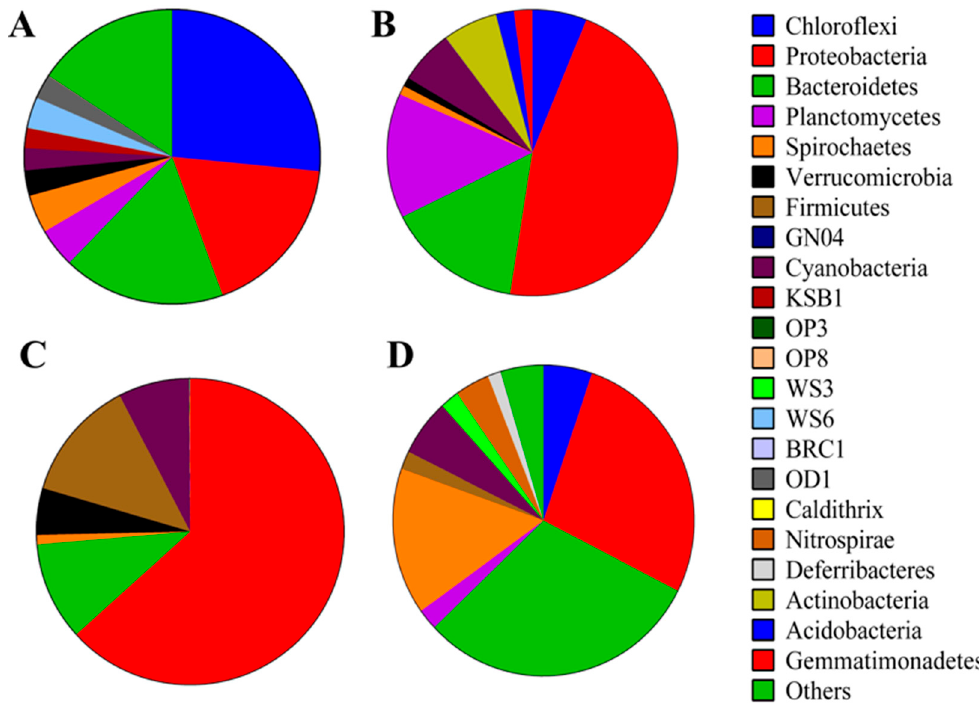
Figure 1. Bacterial diversity of hypersaline mats in ( A ) Guerrero Negro; ( B ) Shark Bay; ( C ) S’Avall; ( D ) Kiritimati Atoll. Proteobacteria are a major member in all four mats while Guerrero Negro is dominated by Chloroflexi, and Kiritimati Atoll dominated by Bacteroidetes. Both Shark Bay and S’Avall mats harbor abundant Proteobacteria. Data obtained from references [2,20–22].